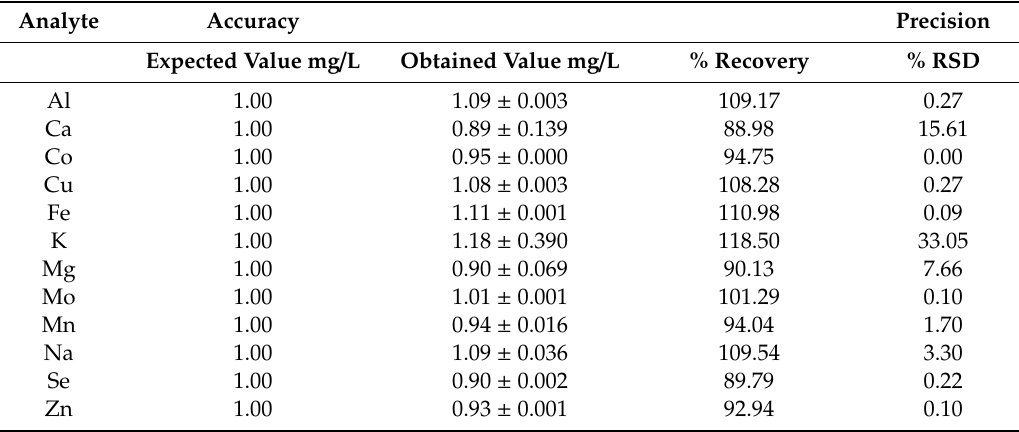
Table 2. Addition and recovery tests to verify method precision for all analytes obtained in ICP-OES (n =